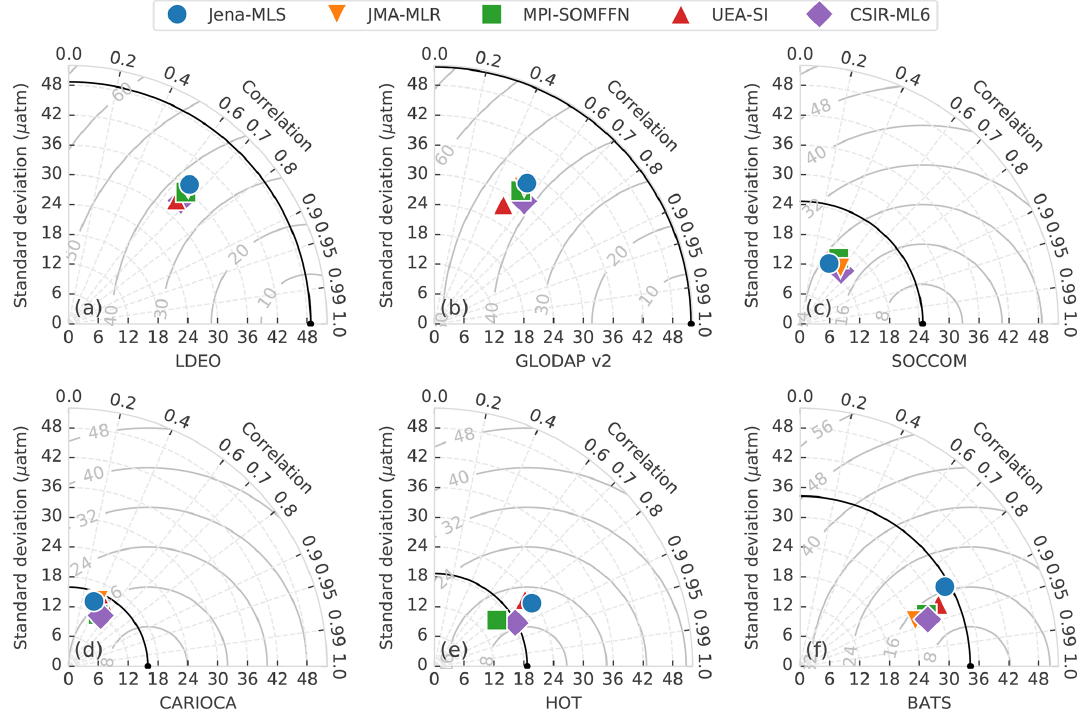
Figure 8. Taylor diagrams comparing the p CO 2 estimates of five gap-filling methods (represented by the different markers) with validation datasets (Table 2) for the period 1990–2015. Each validation dataset has its own Taylor diagram, as labelled on the bottom axes. The black marker on the bottom axis in each subplot represents the validation dataset and the black arc shows the standard deviation thereof. The closer the gap-filling estimates are to this point, the better the model’s performance, in terms of variance, centred RMSE and correlation (for bias information, see Table 5). The solid grey arcs show the centred RMSE for the datasets (with bias removed). A description of the gap-filling methods from independent studies is provided in the text (Sect.